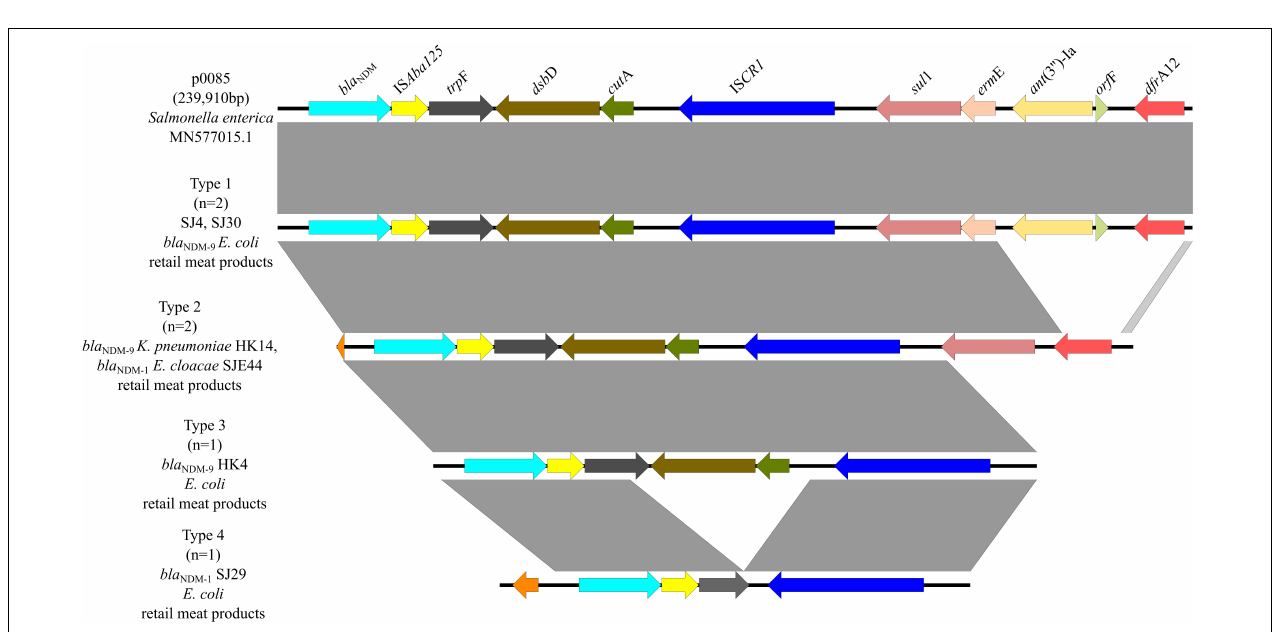
FIGURE 7 | Genetic environments of bla NDM − 1 / 9 in plasmids. Arrows indicate the direction of transcription of the genes, and different colors indicate different genes. Regions of ≥ 99.0% nucleotide sequence identity are shaded gray.